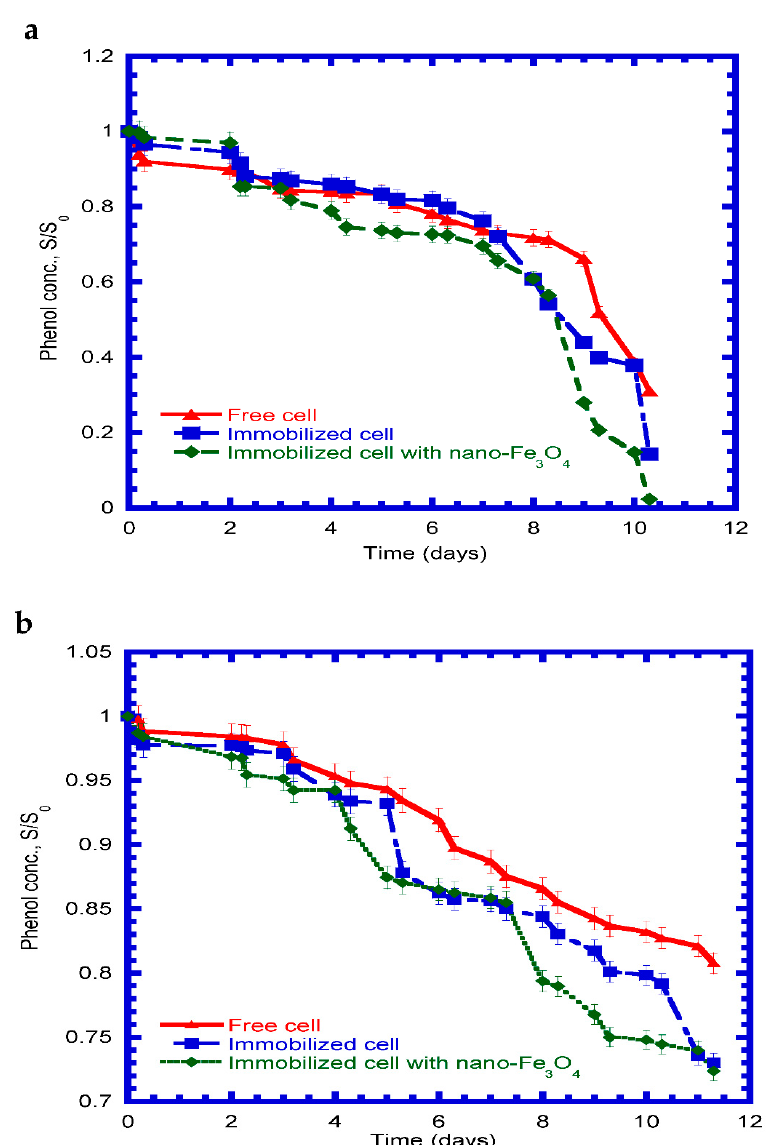
Figure 8. Phenol degradation by Pseudomonas putida in free cells, immobilized cells, and immobilized cells with nano-Fe 3 O 4 in the batch reactors: ( a ) initial phenol concentration is 189.4 mg/L with 1% salinity and 2 g nano-Fe 3 O 4 , and ( b ) initial phenol concentration is 189.2 mg/L with 5% salinity and 2 g nano-Fe 3 O 4 . Table 2. Input parameters to kinetic model of continuous reactor with immobilized cells. Kinetic